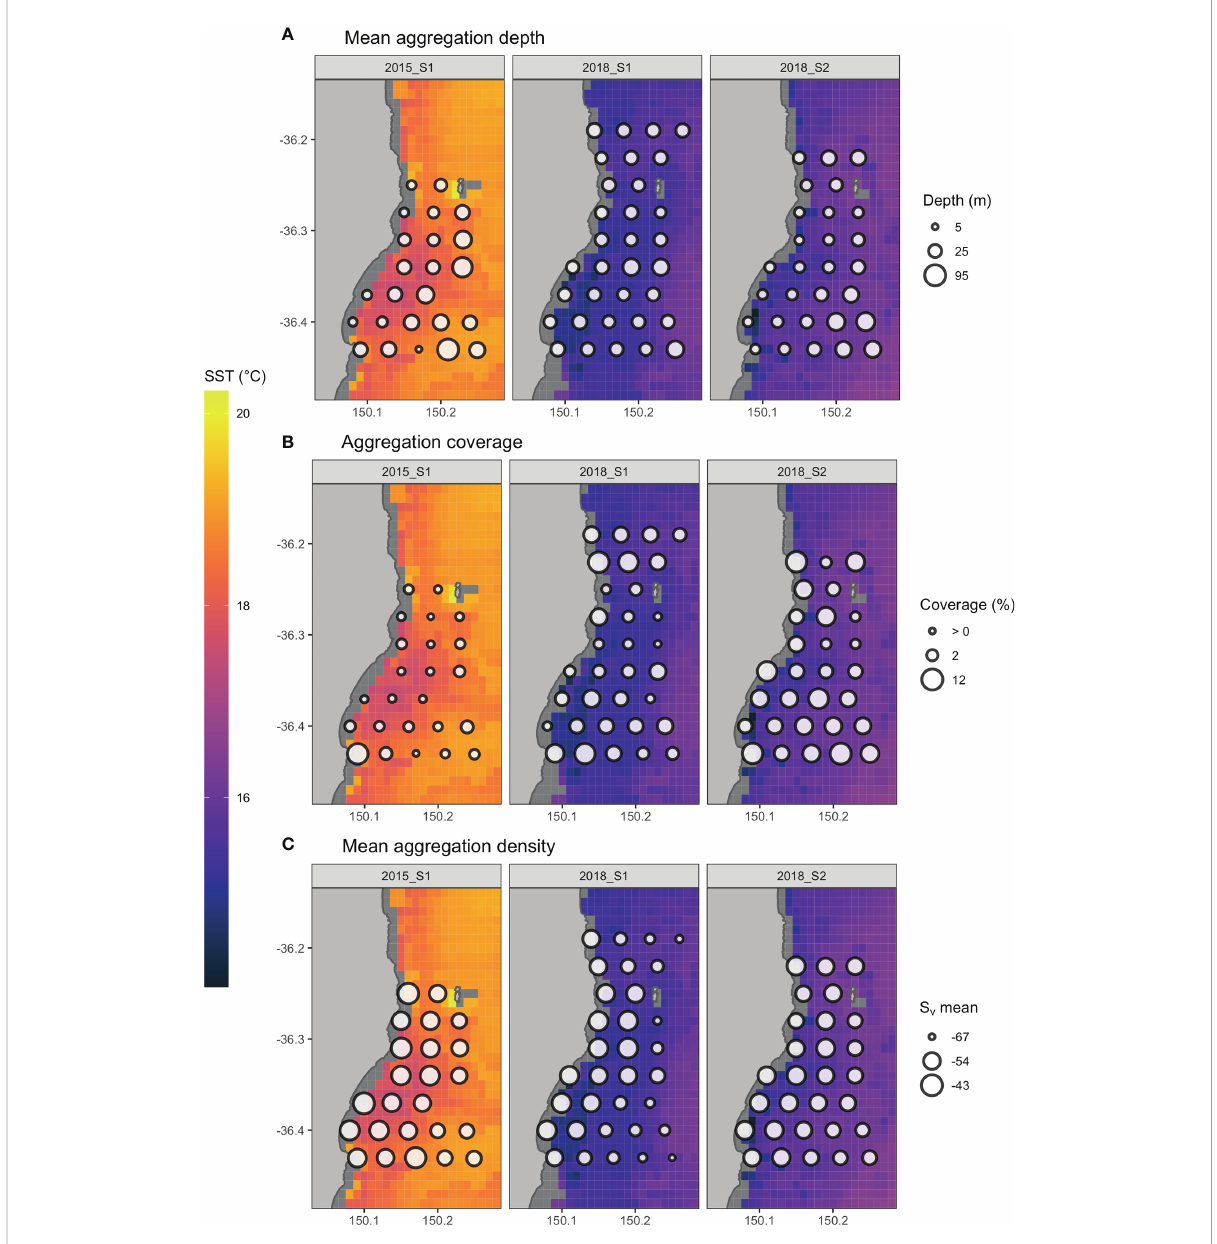
FIGURE 4 Spatial distribution of acoustically derived biological aggregation metrics calculated for the area surrounding transect stations overlaid over sea surface temperature (IMOS MODIS SST) for surveys 2015 S1, 2018 S1 and 2018 S2 with point size representing (A) the mean depth of aggregations, (B) the percentage area around the station containing biological aggregations and (C) the mean aggregation density. An equivalent fi gure for all surveys is included in the supplementary